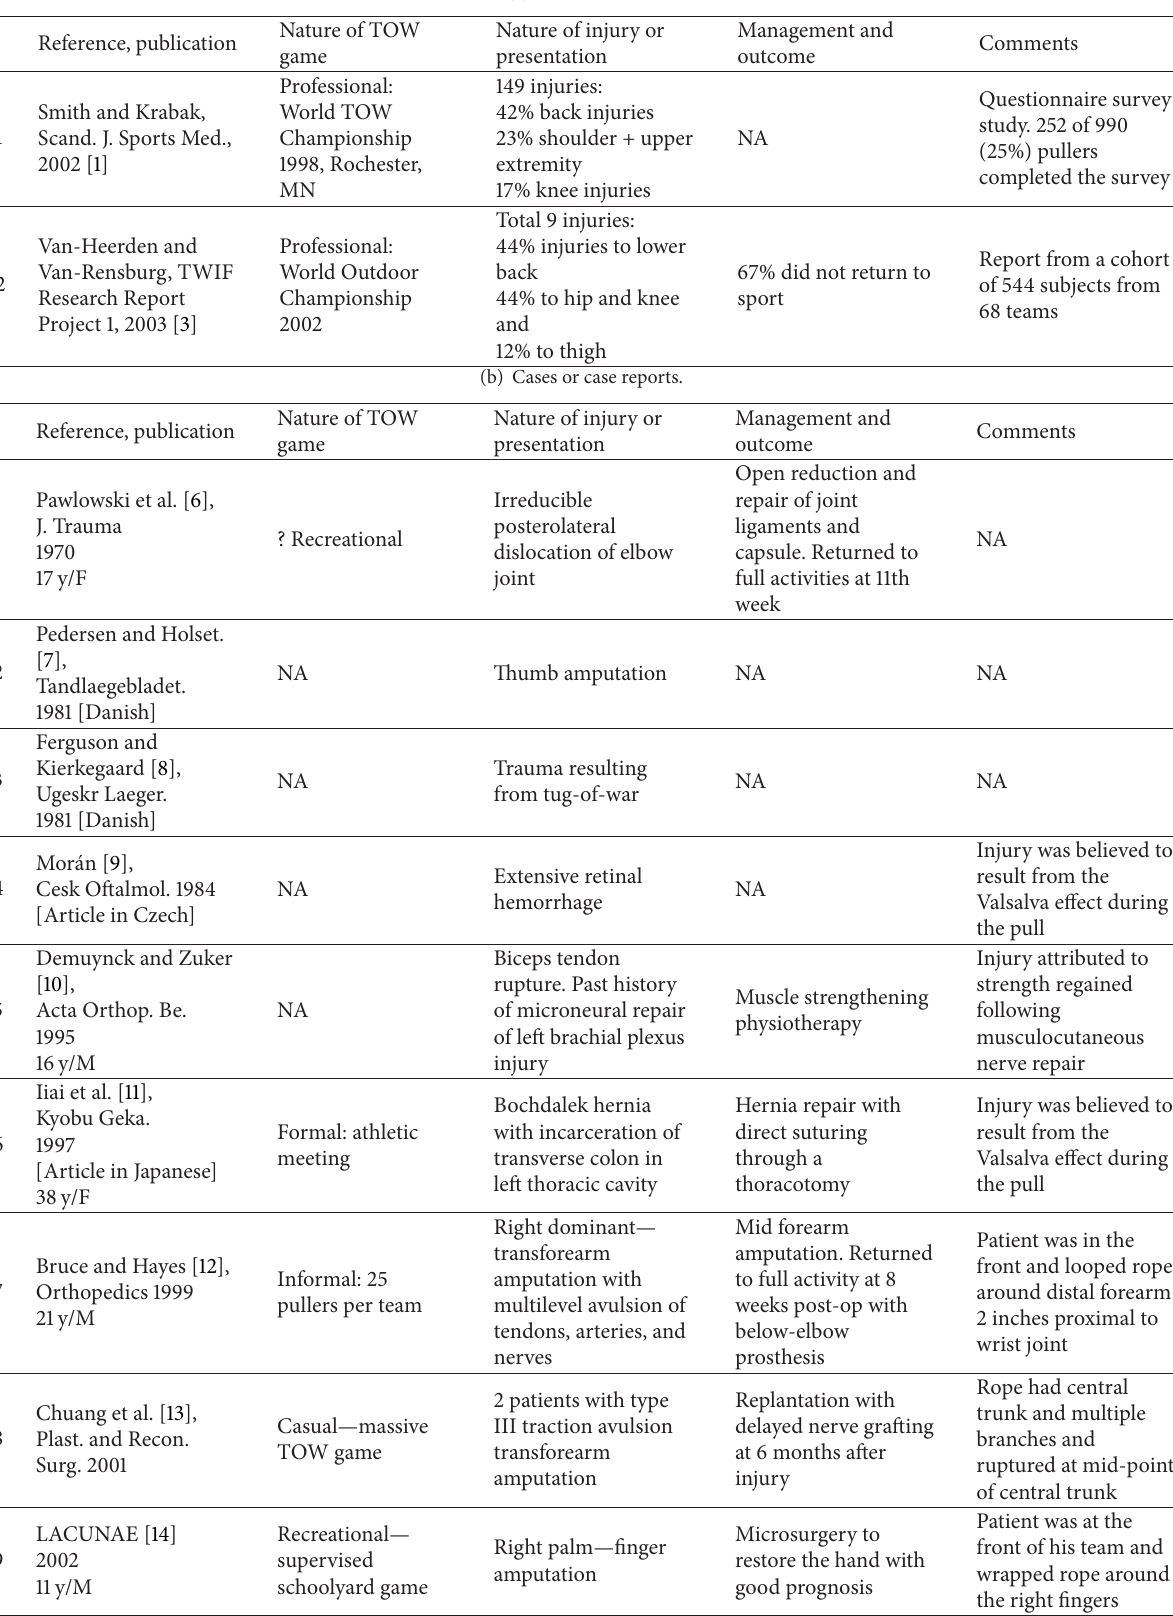
Table 1: Literature review of studies and reports describing TOW-related